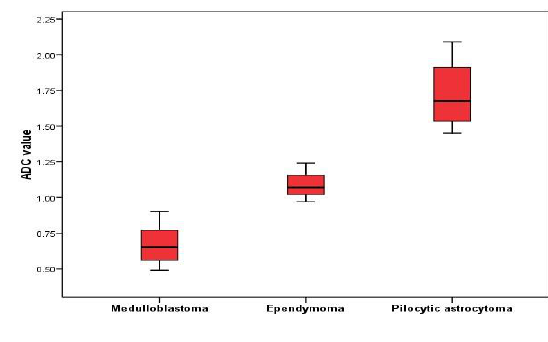
Figure( 1): Box plot of ADC value distribution